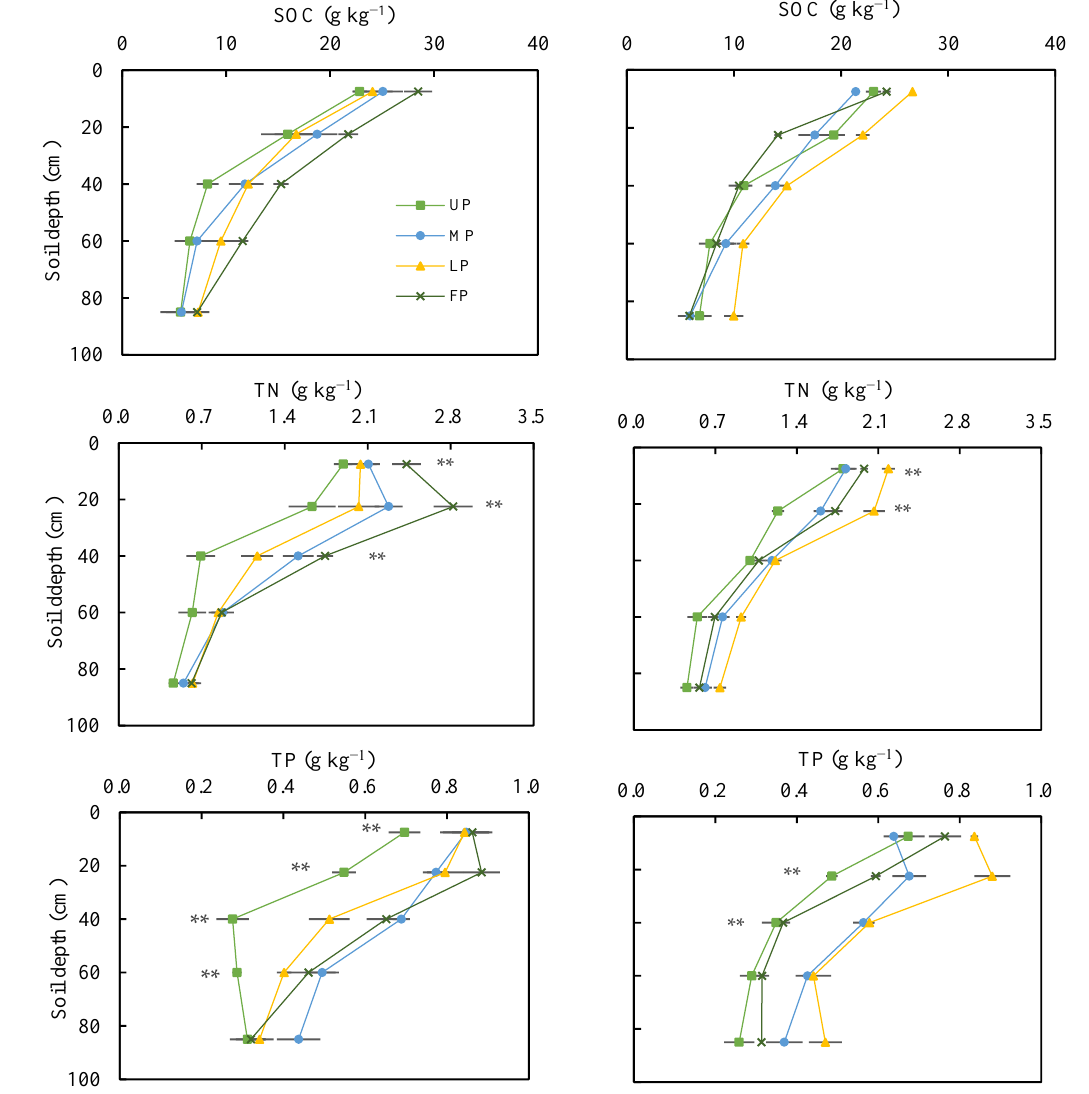
Figure 4. Profile distribution of soil organic matter, total nitrogen, and total phosphorus concentrations at upper slope (UP), middle slope (MP), lower slope (LP), and footslope positions (FP) in sustainable cropland (left) and in conventional cropland (right). SOC: soil organic carbon concentration; TN: total nitrogen concentration; TP: total phosphorus concentration. The error bars are two standard errors of the means. ** indicates that the difference among different slope positions is significant at p < 0.05.